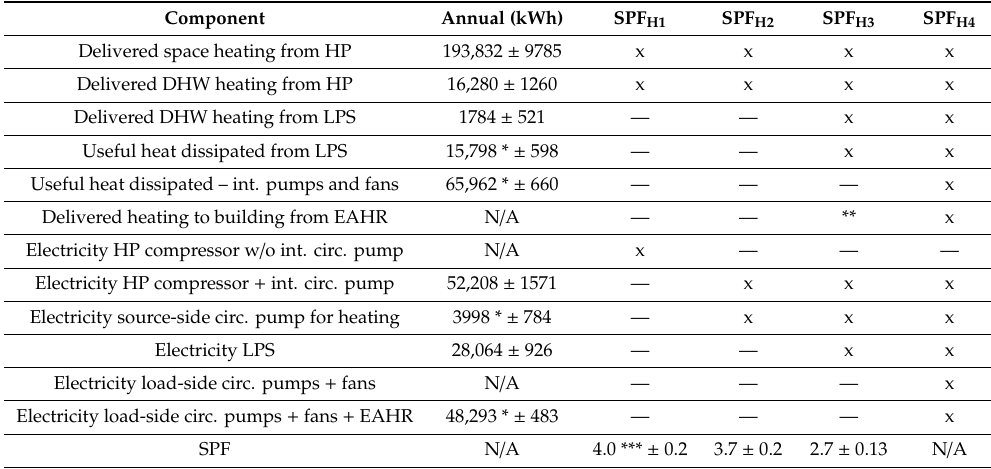
Table 3. Studenthuset heating SPF with SEPEMO system boundaries.